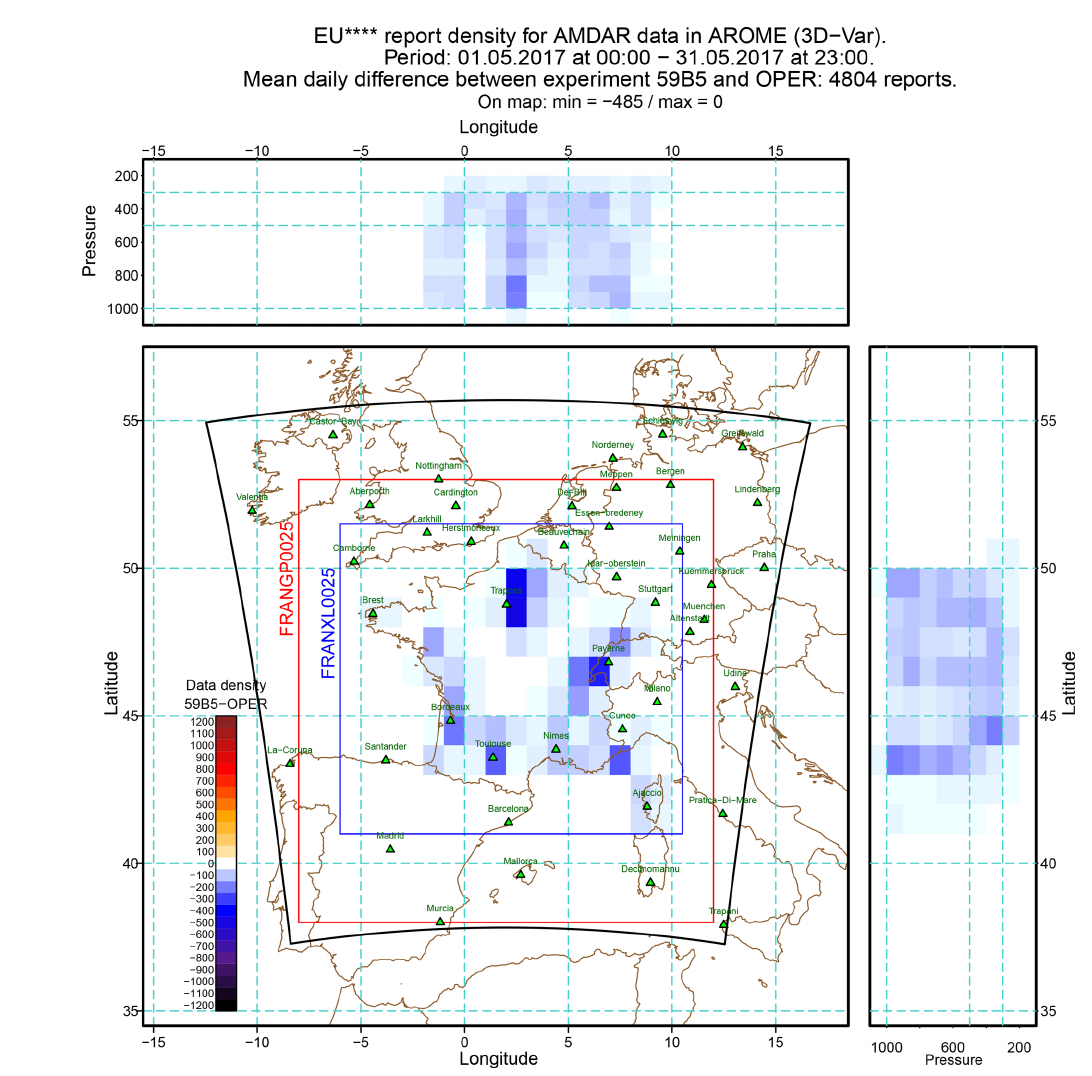
Figure 4. E-AMDAR data density map and vertical cross-sections for the difference between the test experiment and the operational suite in May 2017. The horizontal and vertical resolution of the bins are the same than in Fig. 2. The black line frame highlights the geographical extent of the AROME-France model. The observation change occurs far from the model limits. The red and blue box show the domain on which the verification is performed. Green triangle shows verification radiosounding sites that operate around